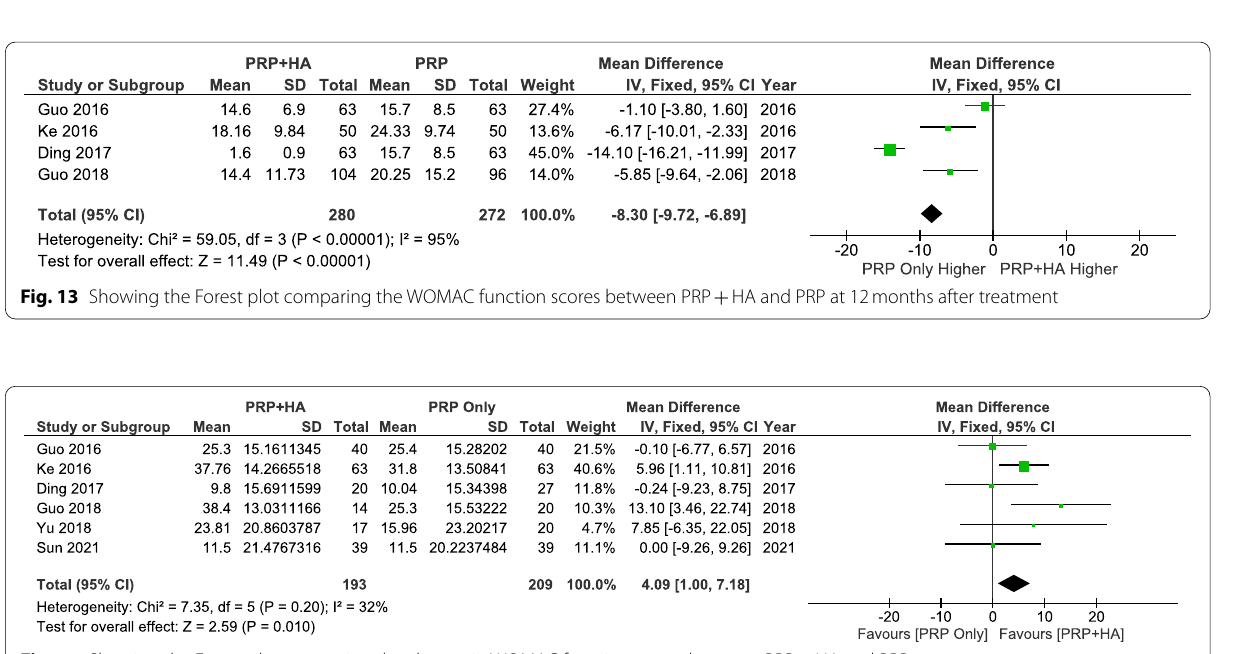
Fig. 14 Showing the Forest plot comparing the change in WOMAC function scores between PRP